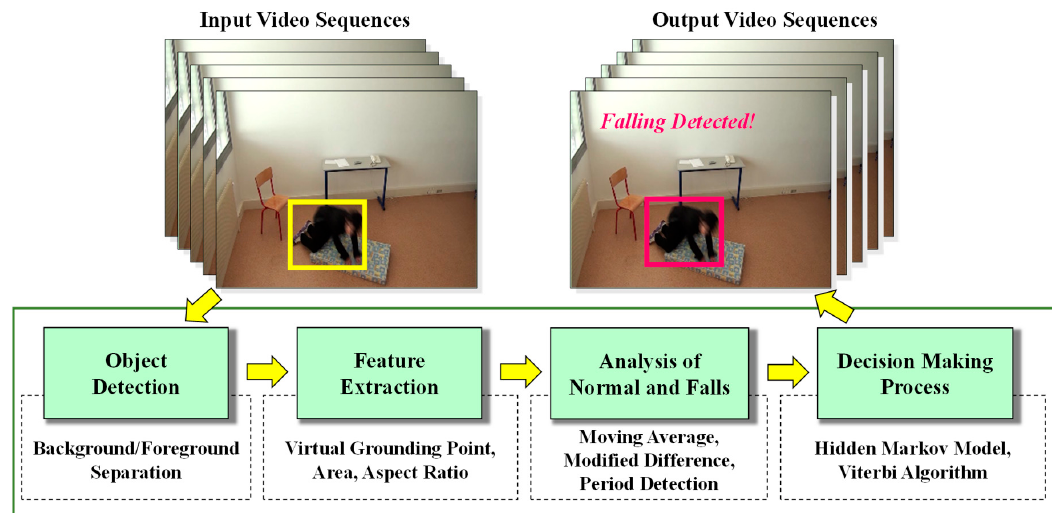
Figure 1. The major work flow of our proposed system.